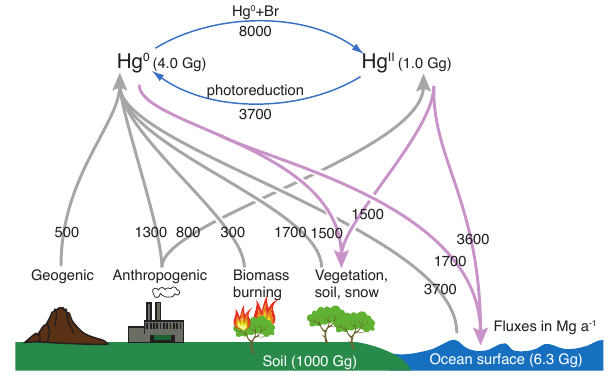
Fig. 1. Global budget of atmospheric mercury derived from this work. Hg II here includes gaseous and particulate forms, plus a neg- ligible contribution (1Mg) from inert particulate